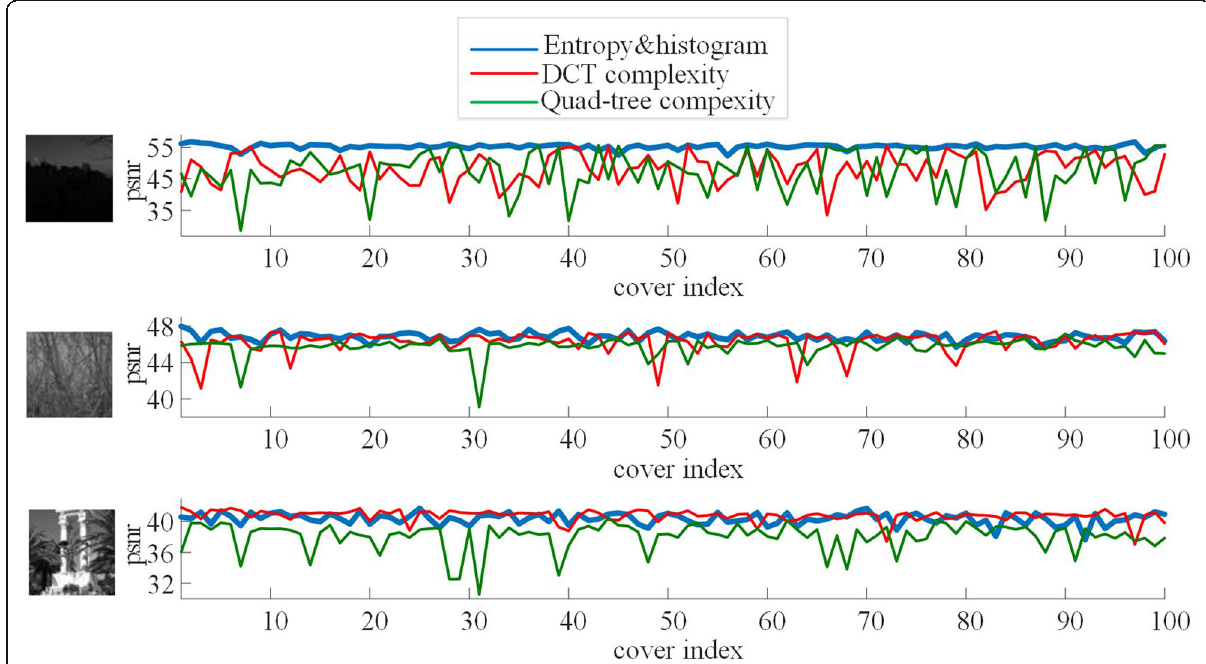
Fig. 3 PSNR for three different secret images and top 100 best covers, chosen by entropy and histogram matching, DCT complexity, and quad- tree complexity